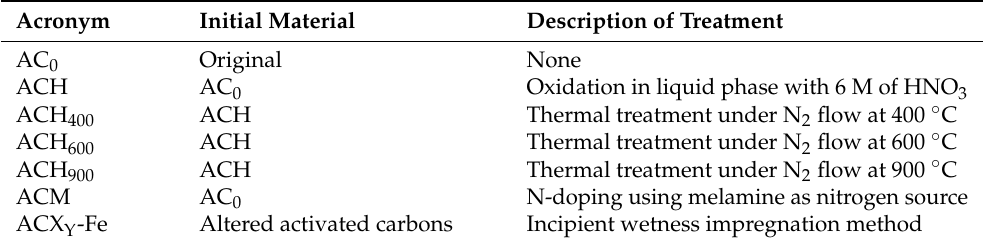
Table 1. Abbreviations of the samples and descriptions of the treatments applied. Acronym Initial Material Description of